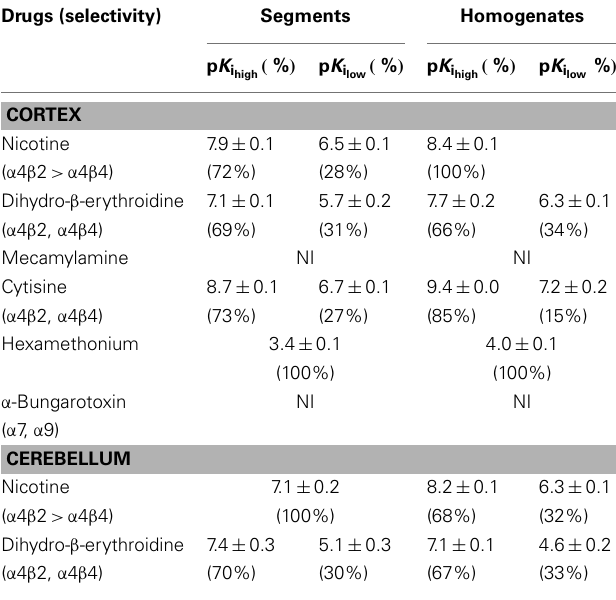
Table 2 | Pharmacological characteristics of [ 3 H]-epibatidine binding sites in rat cortex and